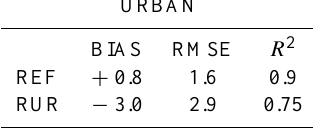
Table 3. Evaluation of the mean bias, rmse (in ◦ C ) and correlation coefficient ( R 2 ) between observations and REF and RUR simula- tions on T2M at Montsouris (URBAN), SIRTA (SUBURBAN) and Trainou (RURAL) sites URBAN